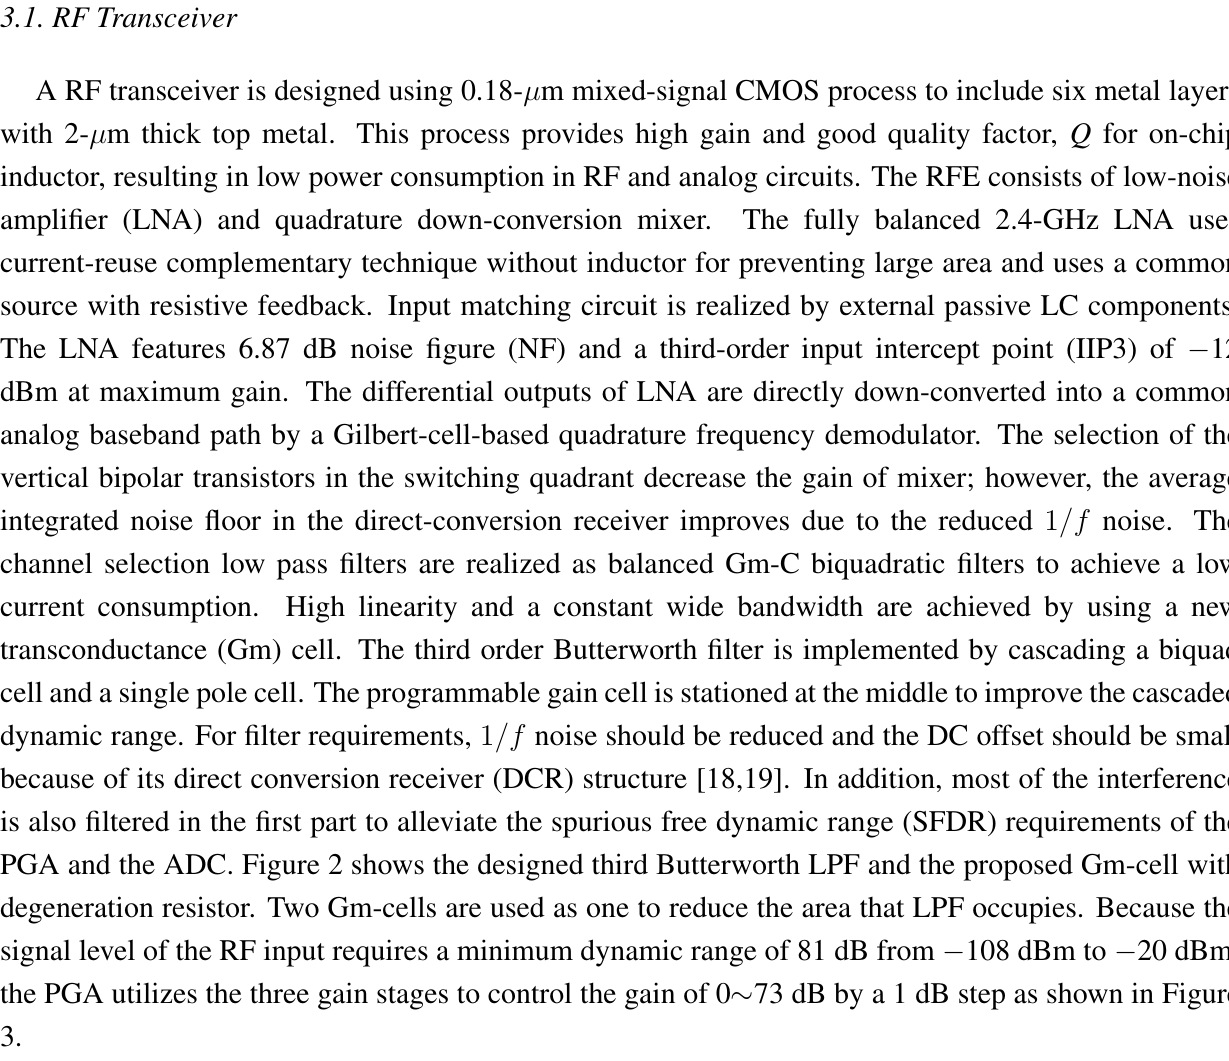
Figure 2. Channel selection filter with third-order Butterworth